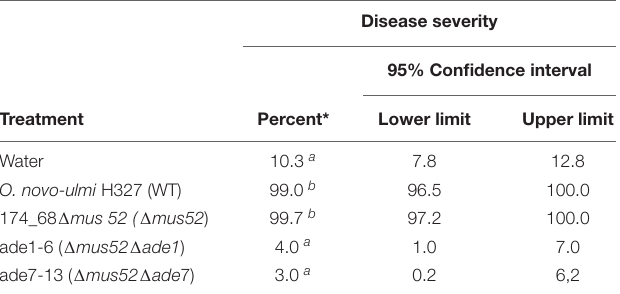
TABLE 1 | Disease severity of Ulmus americana saplings inoculated with Ophiostoma novo-ulmi H327 wild-type, NHEJ-defective mutant strain 174_68 (cid:49) mus52 , and two adenine auxotrophs (ade1-6 and ade7-13) derived from it by targeted deletion of genes ade1 and ade7